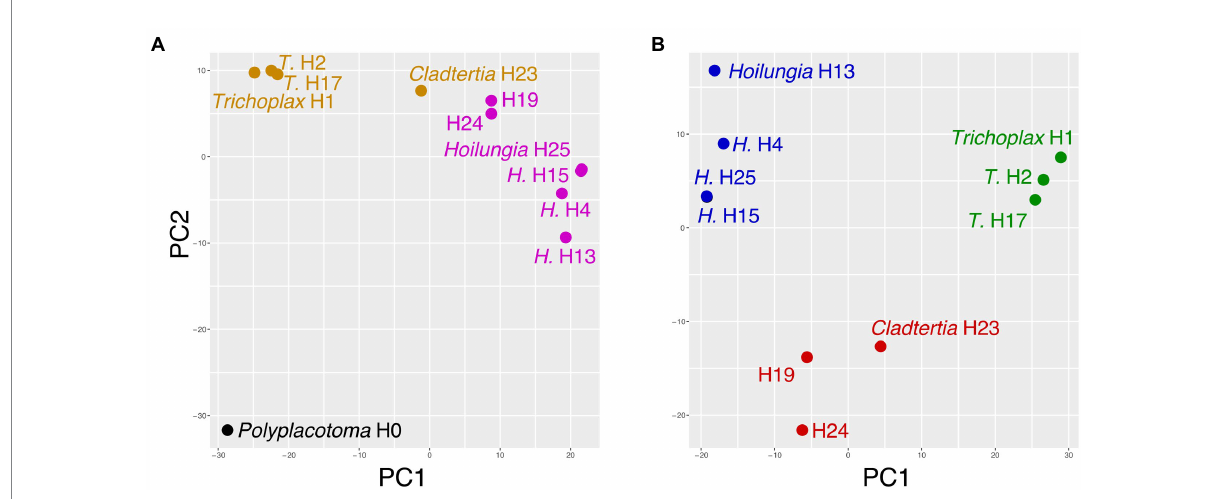
FIGURE 4 Principal components analysis of gene content (i.e., presence/absence). (A) Includes Polyplacotoma mediterranea (variance explained PC1 = 42%, PC2 = 15%). (B) excludes P. mediterranea (variance explained PC1 = 45%, PC2 = 16%), as it is so divergent from the other placozoans. In both plots, coloring is based on clusters selected using affinity propagation on these two datasets.